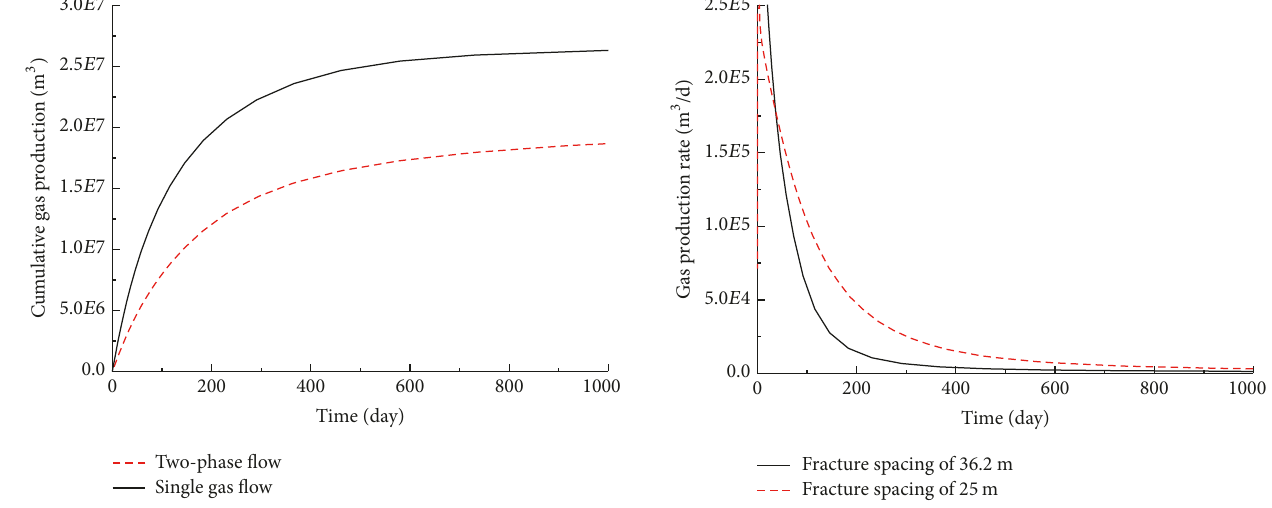
Figure 6: Comparisons of cumulative gas production for single- phase gas flow and two-phase flow.